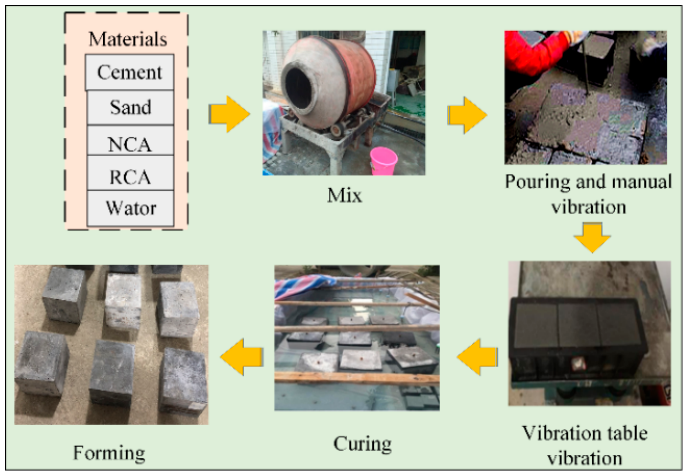
Figure 6. RAC specimen preparation process.